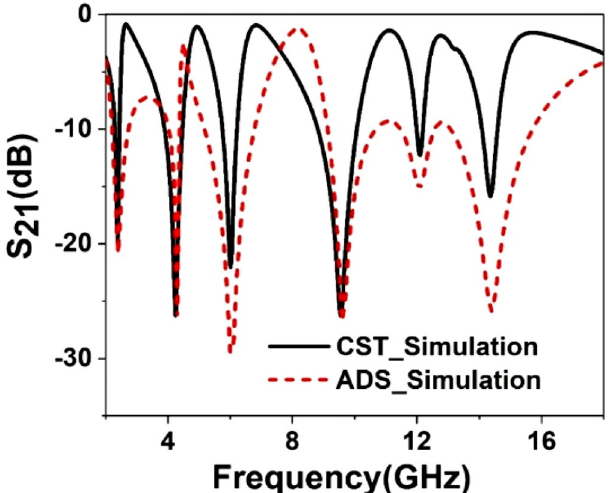
Figure 8. S 21 comparison between ADS and CST Simulation.